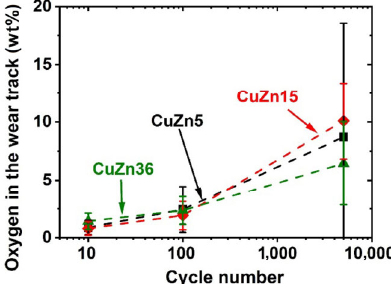
Fig. 5 Mean values for the oxygen concentration within the wear tracks of  -brass samples with 5, 15, and 36 wt% of zinc after 10, 100, and 5,000 sliding cycles, respectively. Line scans perpendicular to the wear tracks were performed with a FIB/SEM DualBeam system using an EDS detector (accelerating voltage of 10 keV, beam current of 0.8